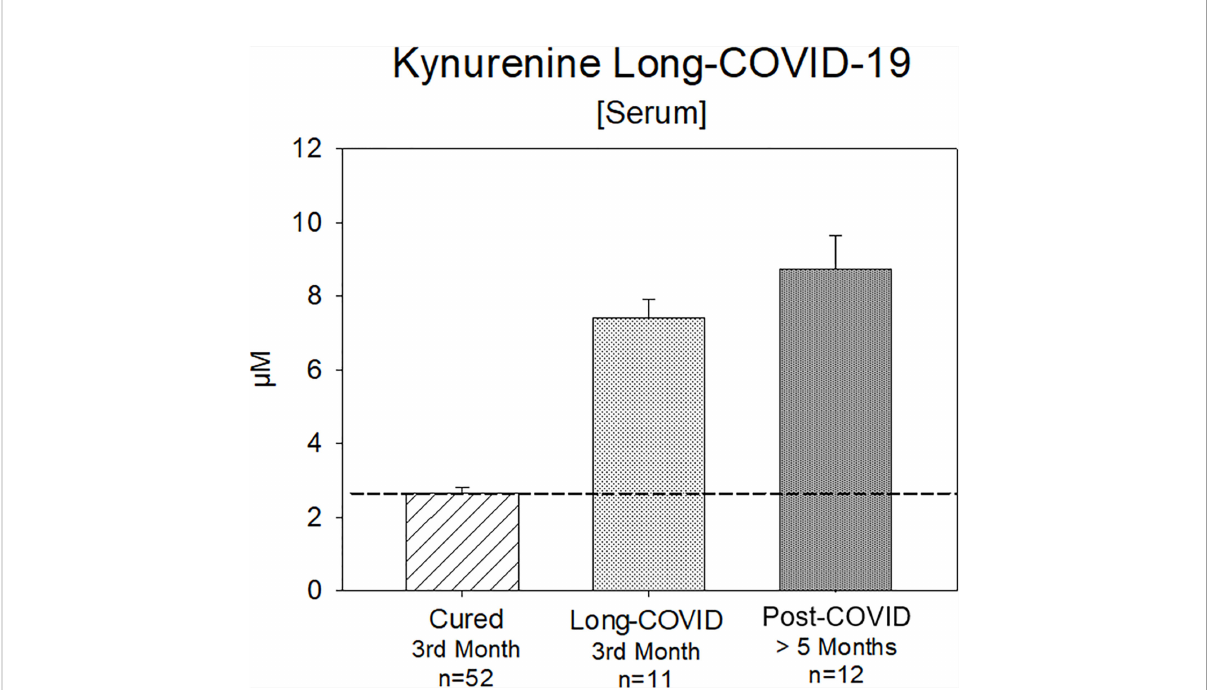
FIGURE 6 Kynurenine (Serum) in the 3rd month after positive PCR-testing: either cured or with a Long-COVID syndrome for 3 months or Post-COVID syndrome more than 5 months in a subset of Group B Kynurenine is still signi fi cantly increased, whereas the values of the cured patients are in a normal